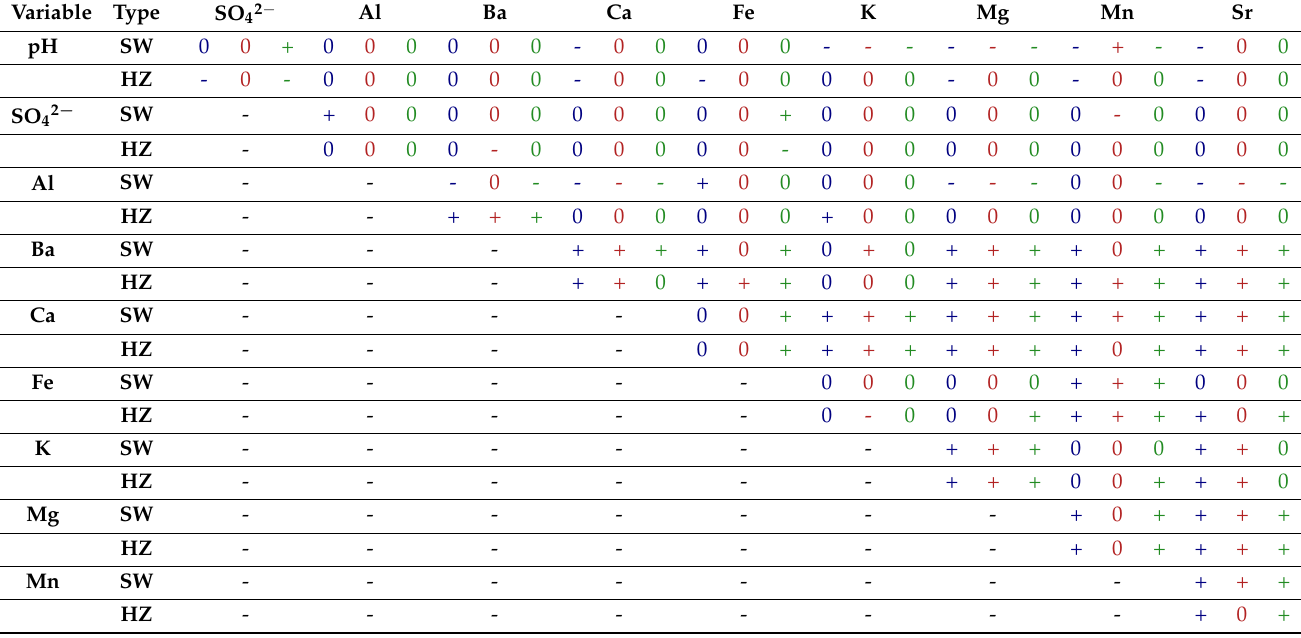
Table 4. Spearman correlation information for GR (blue) , SB (red) , and TC (green) for pH, sulfate, and dissolved metal concentrations. Measurements from both surface water (SW) and subsurface water, collected from the hyporheic zone (HZ), are included. Symbols are identical to Table 3. See Table S6 for r